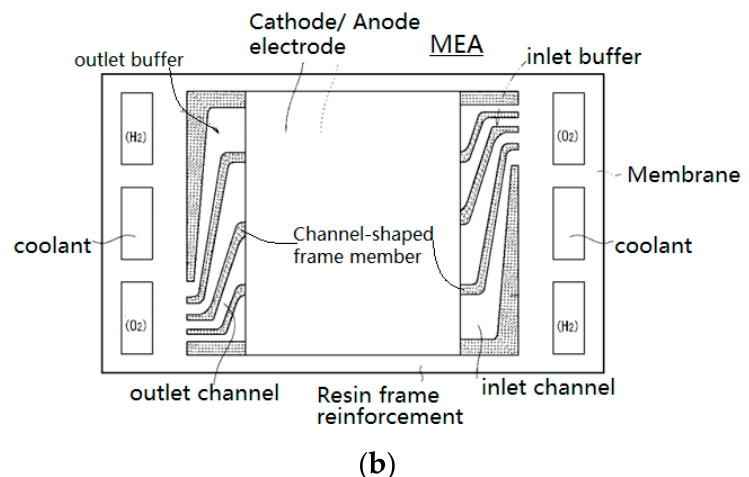
Figure 4. Schematic diagrams of the frame directly bonded to the separator. ( a ) frame as a sealing member [28]; ( b ) channel-shaped members formed on the resin frame [29].